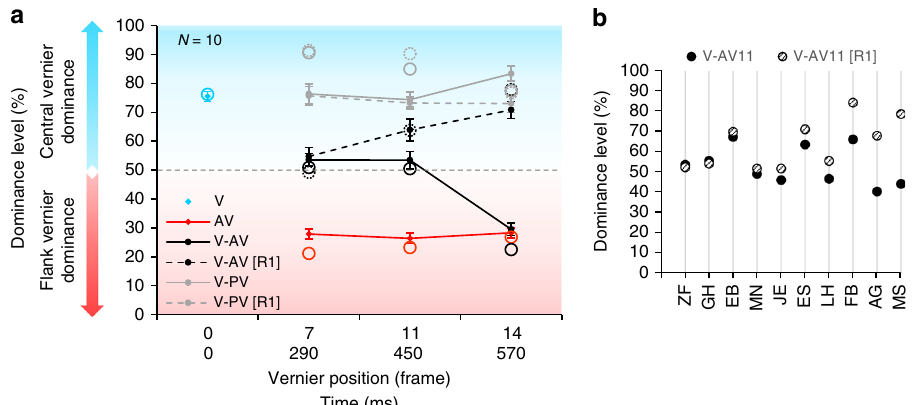
Fig. 2 Results of experiment 1. a We presented the central vernier and, in addition, one fl ank vernier in frame 7, 11, or 14, respectively (290 ms, 450 ms, or 570 ms). Data is displayed as vernier dominance: the percentage of observers ’ responses in accordance with the central vernier. A dominance level above 50% (blue part of the plot) indicates that the central vernier dominates performance; a dominance level below 50% (red part of the plot) indicates that the anti-vernier dominates performance. In the fi rst part of the experiment, observers were naive (solid lines). In the second part of the experiment, they were informed about the paradigm and instructed to report the central vernier offset ([R1], dashed lines). Mandatory integration lasts up to 450 ms, depending on the observer. Performance of a two-stage model (see Fig. 5) is presented by empty circles. The experimental data is well predicted. Error bars